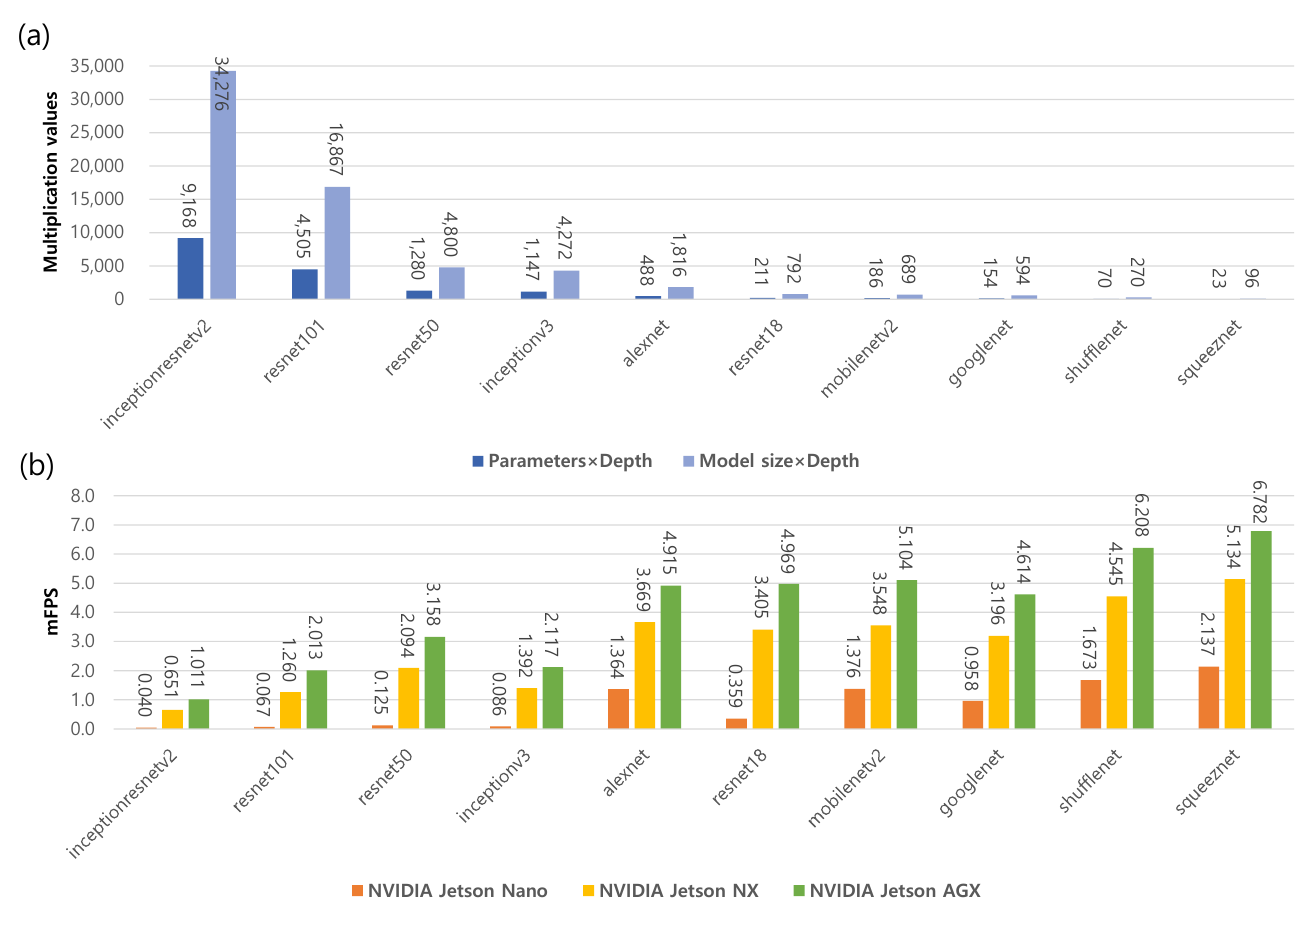
Figure 7. Runtime performance evaluation considering the DL models and NVIDIA GPU platforms. ( a ) Multiplication values for the ten DL models. ( b ) The mFPS of the NVIDIA GPU platforms with the ten DL